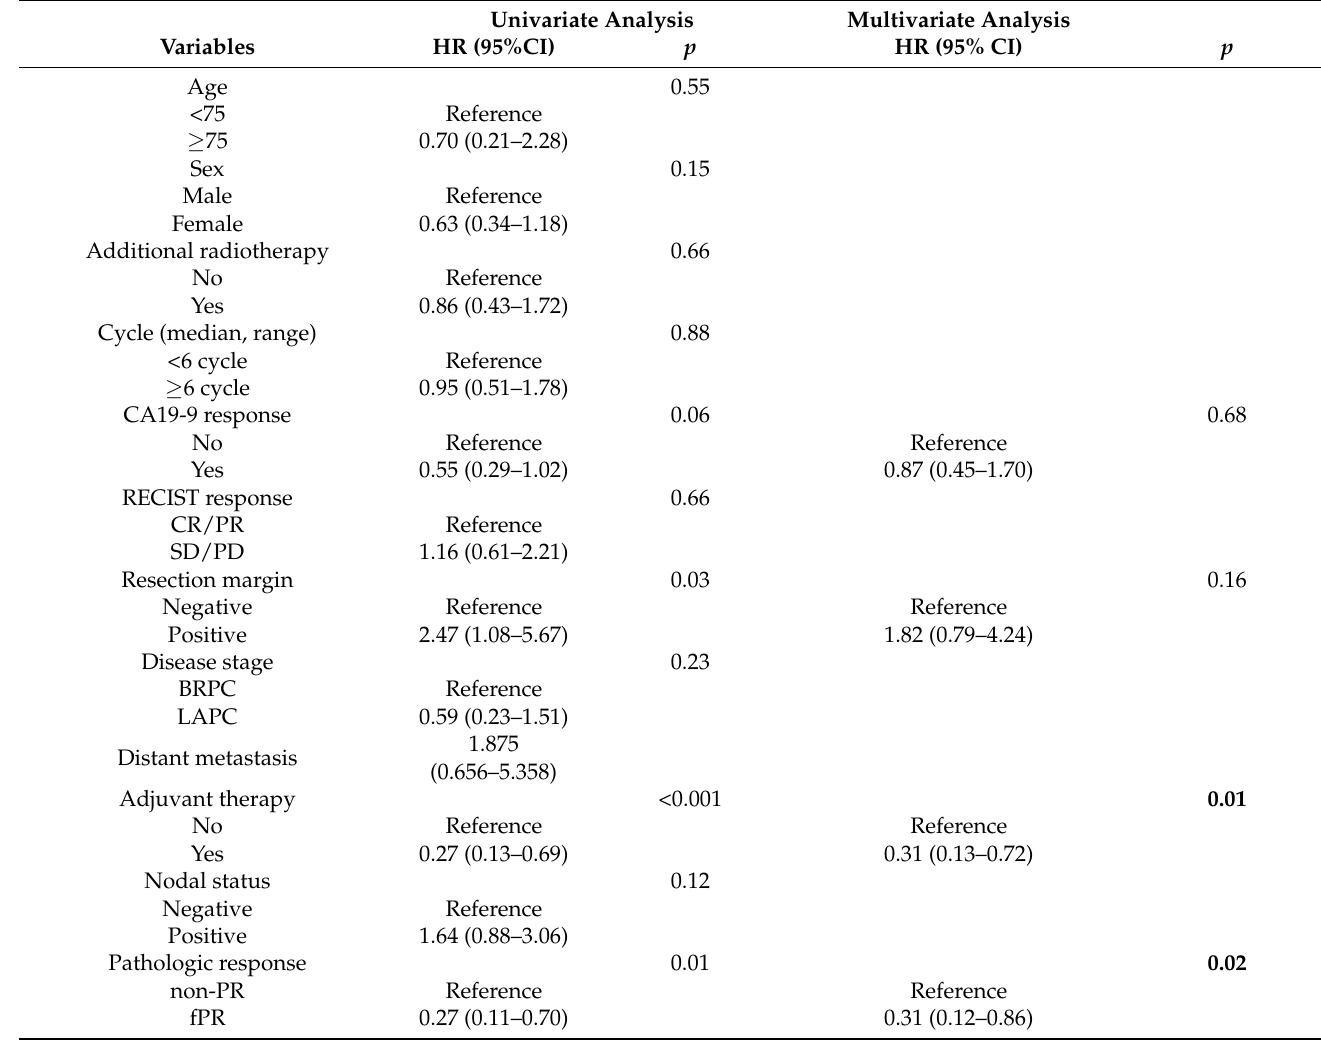
Table 3. Analysis for the association between disease-free survival and clinical characteristics. Univariate Analysis Multivariate